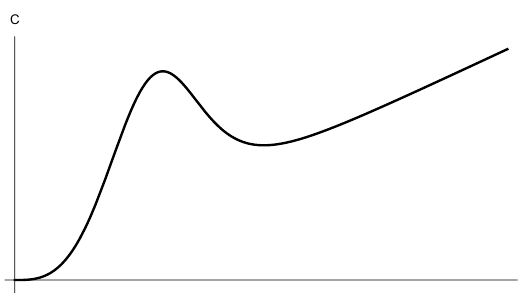
Figure 7 . Specific heat for negative